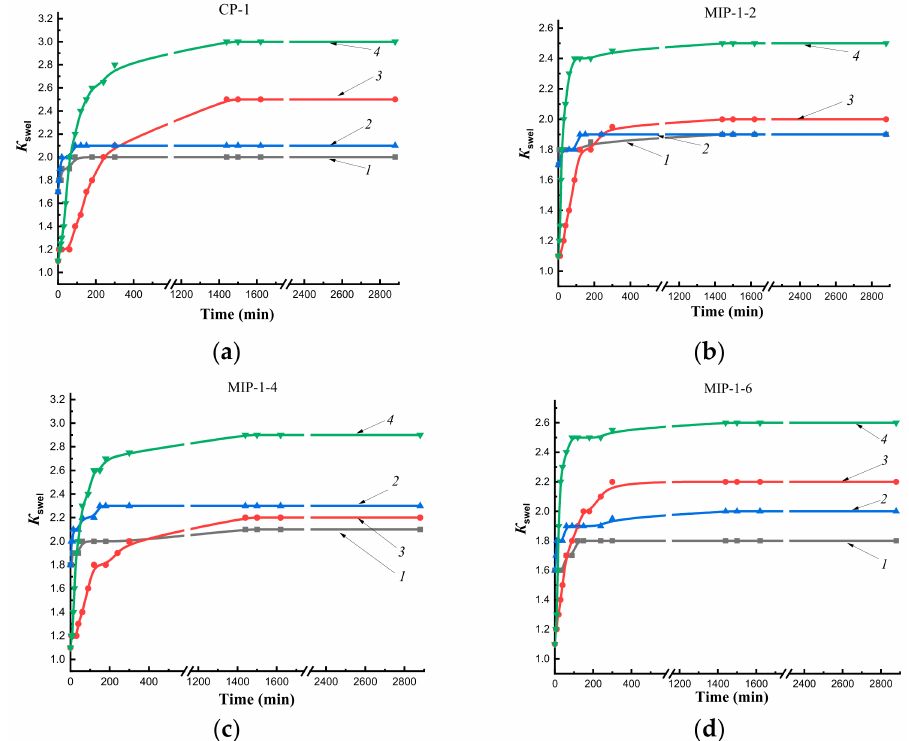
Figure 5. Kinetics of swelling sorbents obtained by Method 1 in water and n-propyl alcohol at temperatures of 25 ◦ C and 37 ◦ C: CP-1 ( a ), MIP-1-2 ( b ), MIP-1- 4 ( c ), MIP-1-6 ( d ); 1 —in water at 25 ◦ C; 2 —in water at 37 ◦ C; 3 —in n-propyl alcohol at 25 ◦ C; 4 —in n-propyl alcohol at 37 ◦